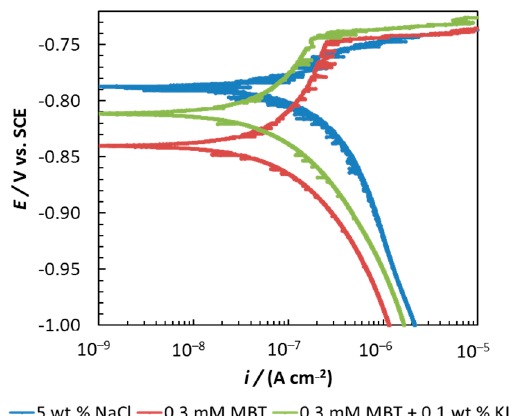
Figure 7. Potentiodynamic curves for the AA6082 aluminium alloy samples after 11 h of immersion at 25 °C in 5 wt.% NaCl solution containing 0.3 mM MBT or a combination of 0.3 mM MBT and 0.1 wt.% KI.